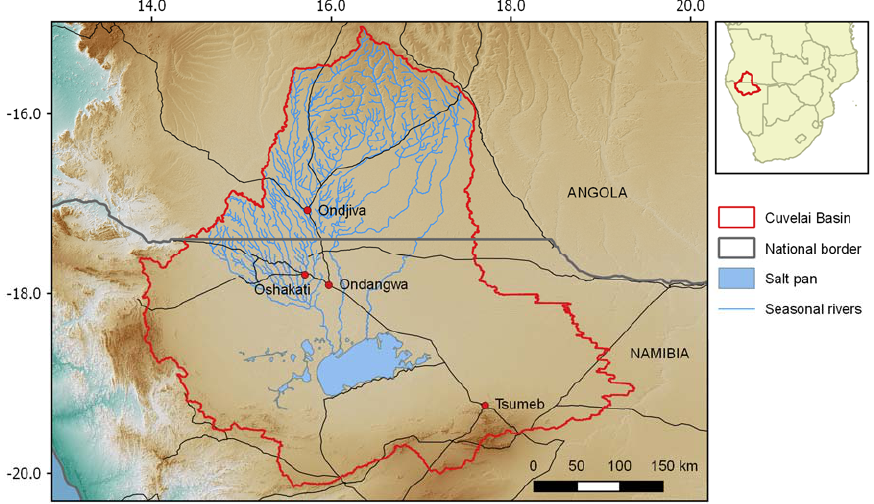
Figure 1. Cuvelai-Basin in Angola and Namibia.